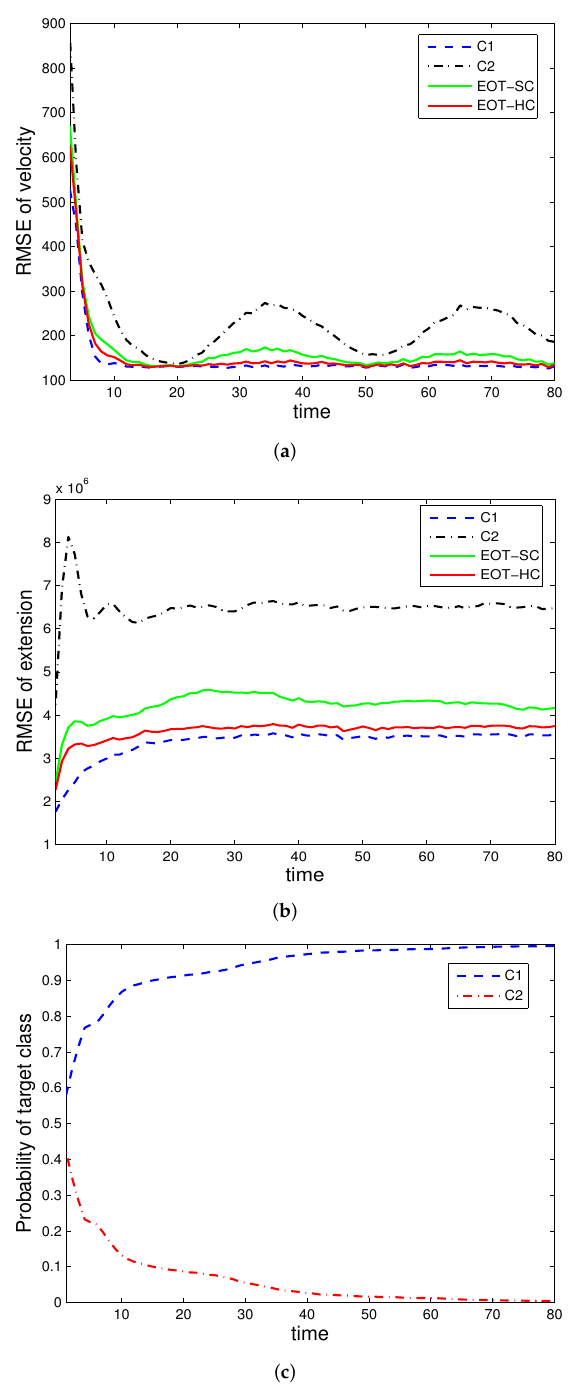
Figure 3. EOT-SC and EOT-HC using multisensor data, class c 1 is true: ( a ) RMSE of velocity, ( b ) RMSE of extension, ( c ) Probability of target